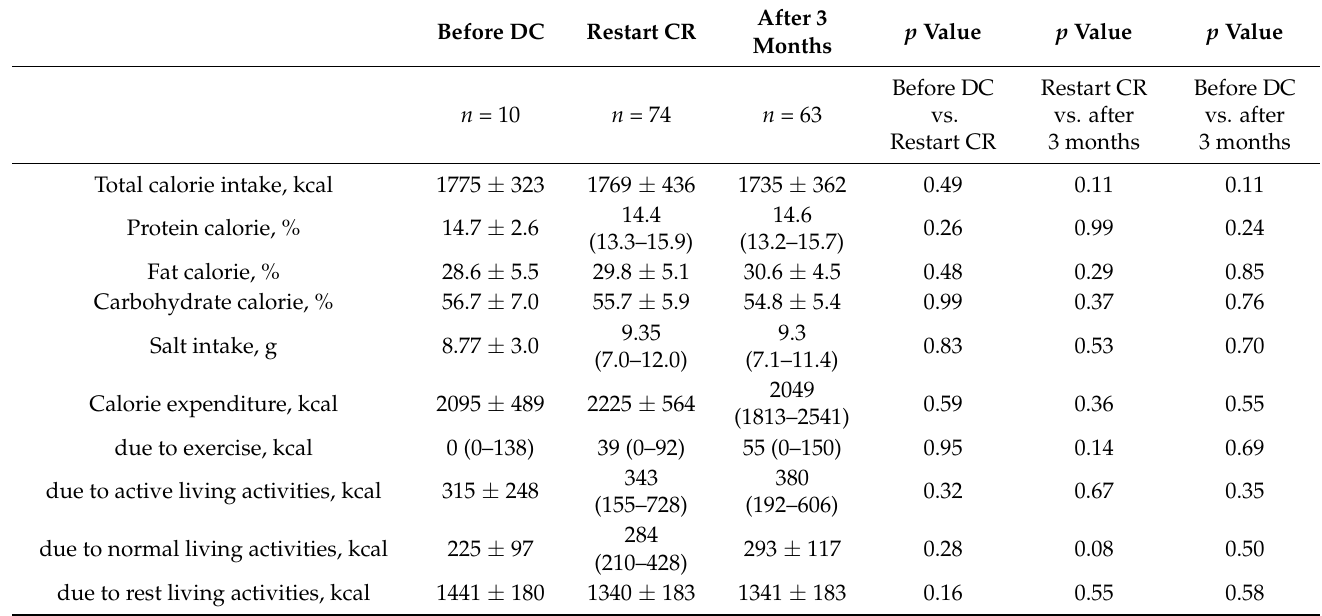
Table 2. The changes of FFQ before DC, at restart CR and after 3